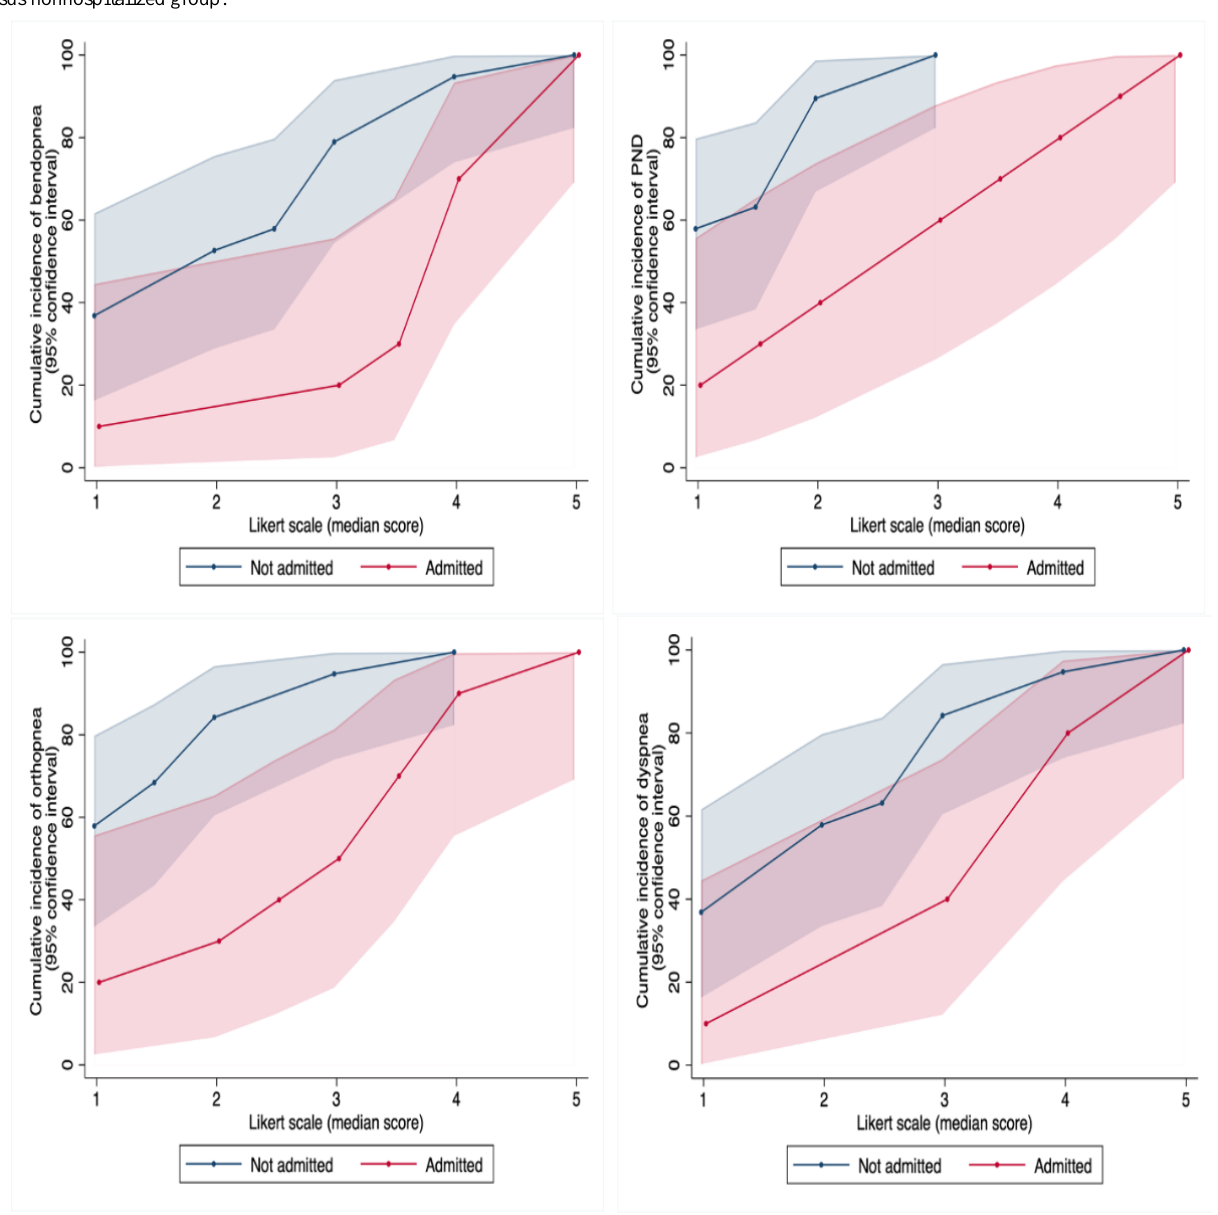
Figure 1. Subjective symptom measurements experienced at each severity level of the Likert scale, showing the weighting of severity in the hospitalized versus nonhospitalized